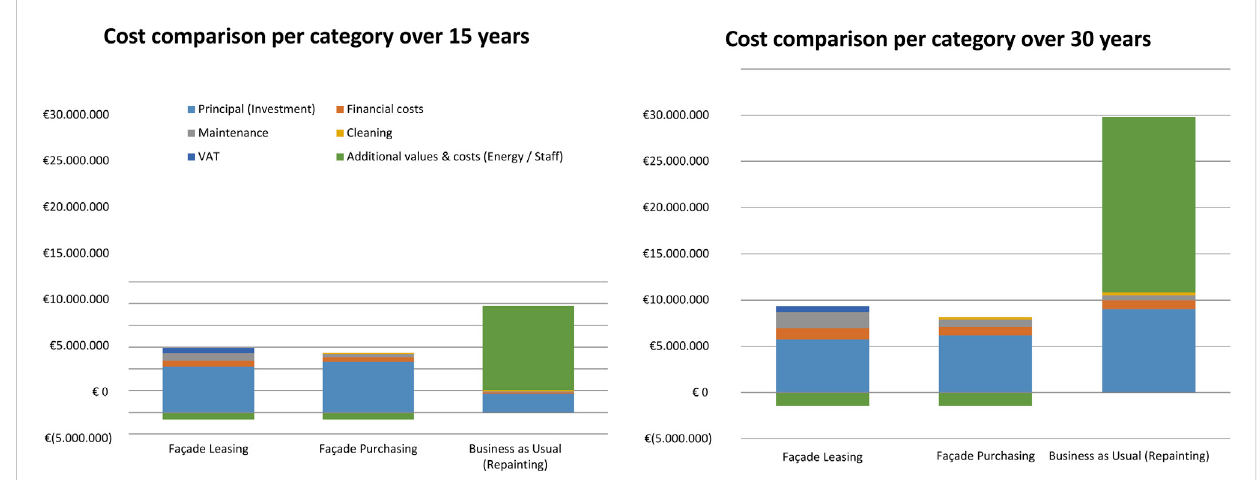
FIGURE 6 TotalValueofOwnershipresultscomparingthethreestrategicscenariosfortheCitGEastfaçaderenovation,includingselected “ soft ” values,overa 15- and 30-year planning horizon. First published in (Azcarate-Aguerre et al.,